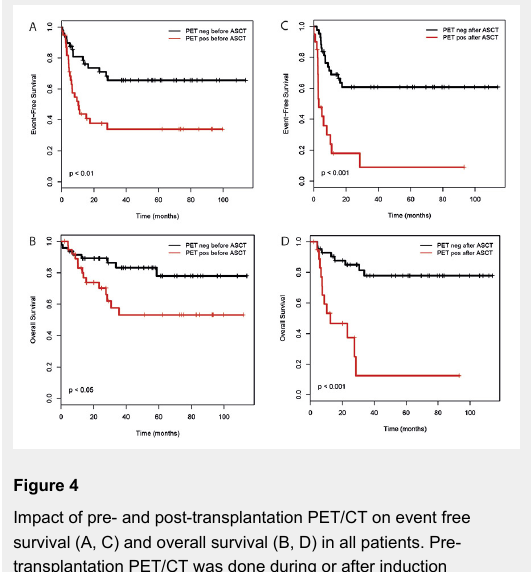
Impact of pre- and post-transplantation PET/CT on event free survival (A, C) and overall survival (B, D) in all patients. Pre- transplantation PET/CT was done during or after induction chemotherapy, post-transplantation PET/CT was done within 3 months after ASCT.